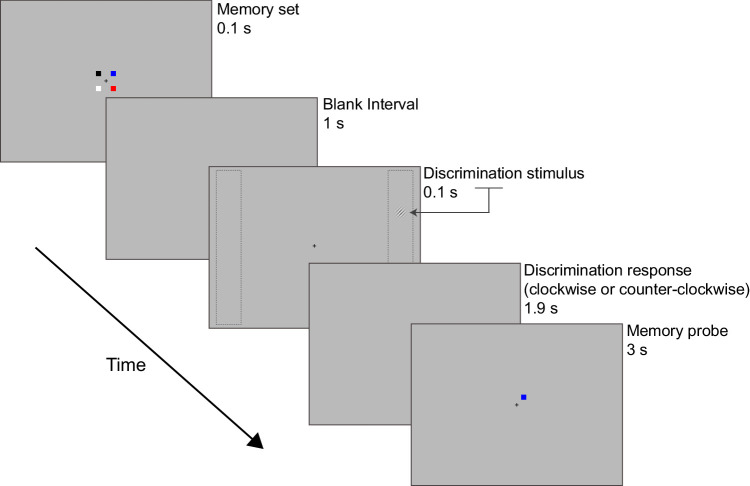
Displays of an example high VSTM load trial in Experiment 1. Four squares in high load (or one square in low load) were presented at the center of the screen. Following a 1-second interval, a tilted target Gabor patch appeared within a left or right columnar bar (shown as gray dashed lines here but not presented during the experiment). Participants maintained the memory set while reporting (during the delay period) the orientation (clockwise or counterclockwise) of the peripheral Gabor patch. The correct response here is counterclockwise. The memory probe appeared next for 3 seconds or until response. Participants indicated with a button press whether the location and color of the memory probe matched that of the memory set. The correct response here is “same.”